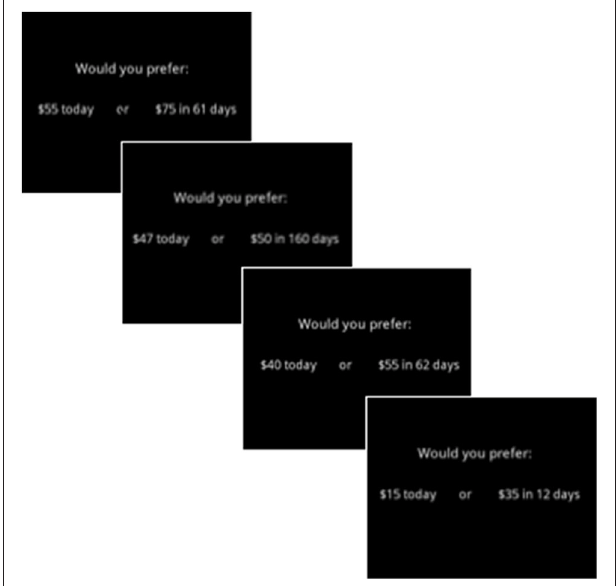
FIGURE 2 | Schematic depicting the trial sequence in the Cued Reinforcement Reaction Time (CRRT) task ( 38). In this example, 100 points are awarded for a fast response on a high probability reinforcement trial.